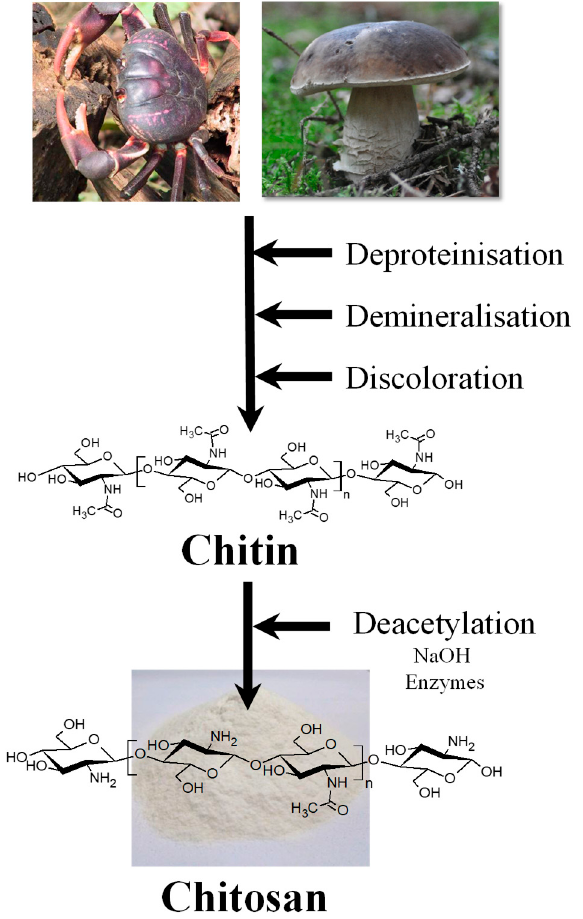
Figure 2. General steps for chitin and chitosan production.